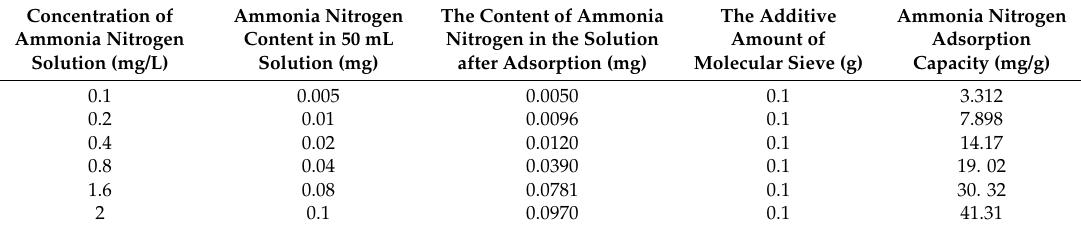
Table 4. Removal of ammonia nitrogen from G-SBA-15-SH molecular